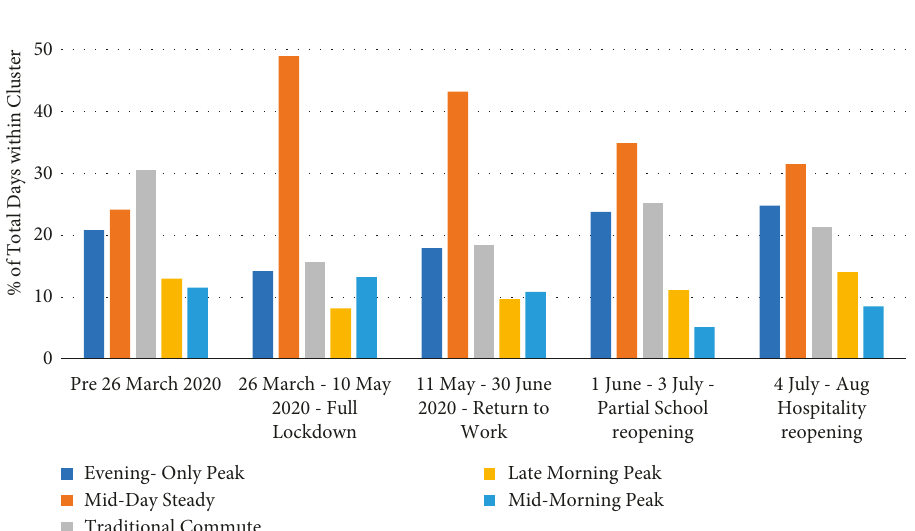
Figure 9: Changing flow profiles during each stage of